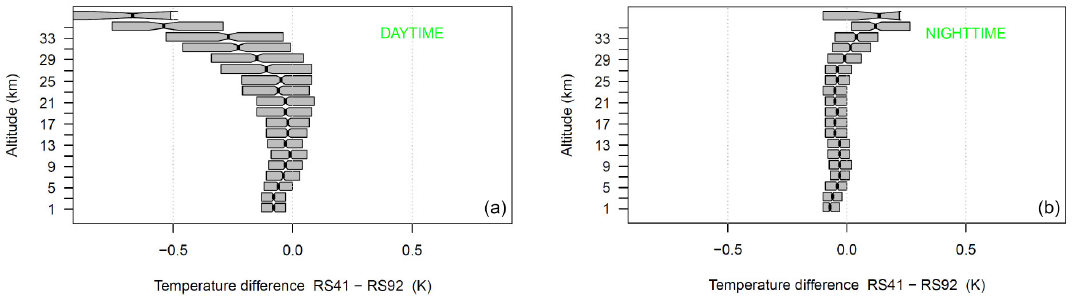
Figure 1. Temperature deviation of RS41 with respect to RS92 calculated from the GRUAN multi-payload flights dataset during June 2015–December 2018. The boxes are centred in the mean bias and span the 25th–75th percentile range. Statistics are based on 58 flights at 11:00UTC (a) and 59 flights at 23:00UTC (b) .